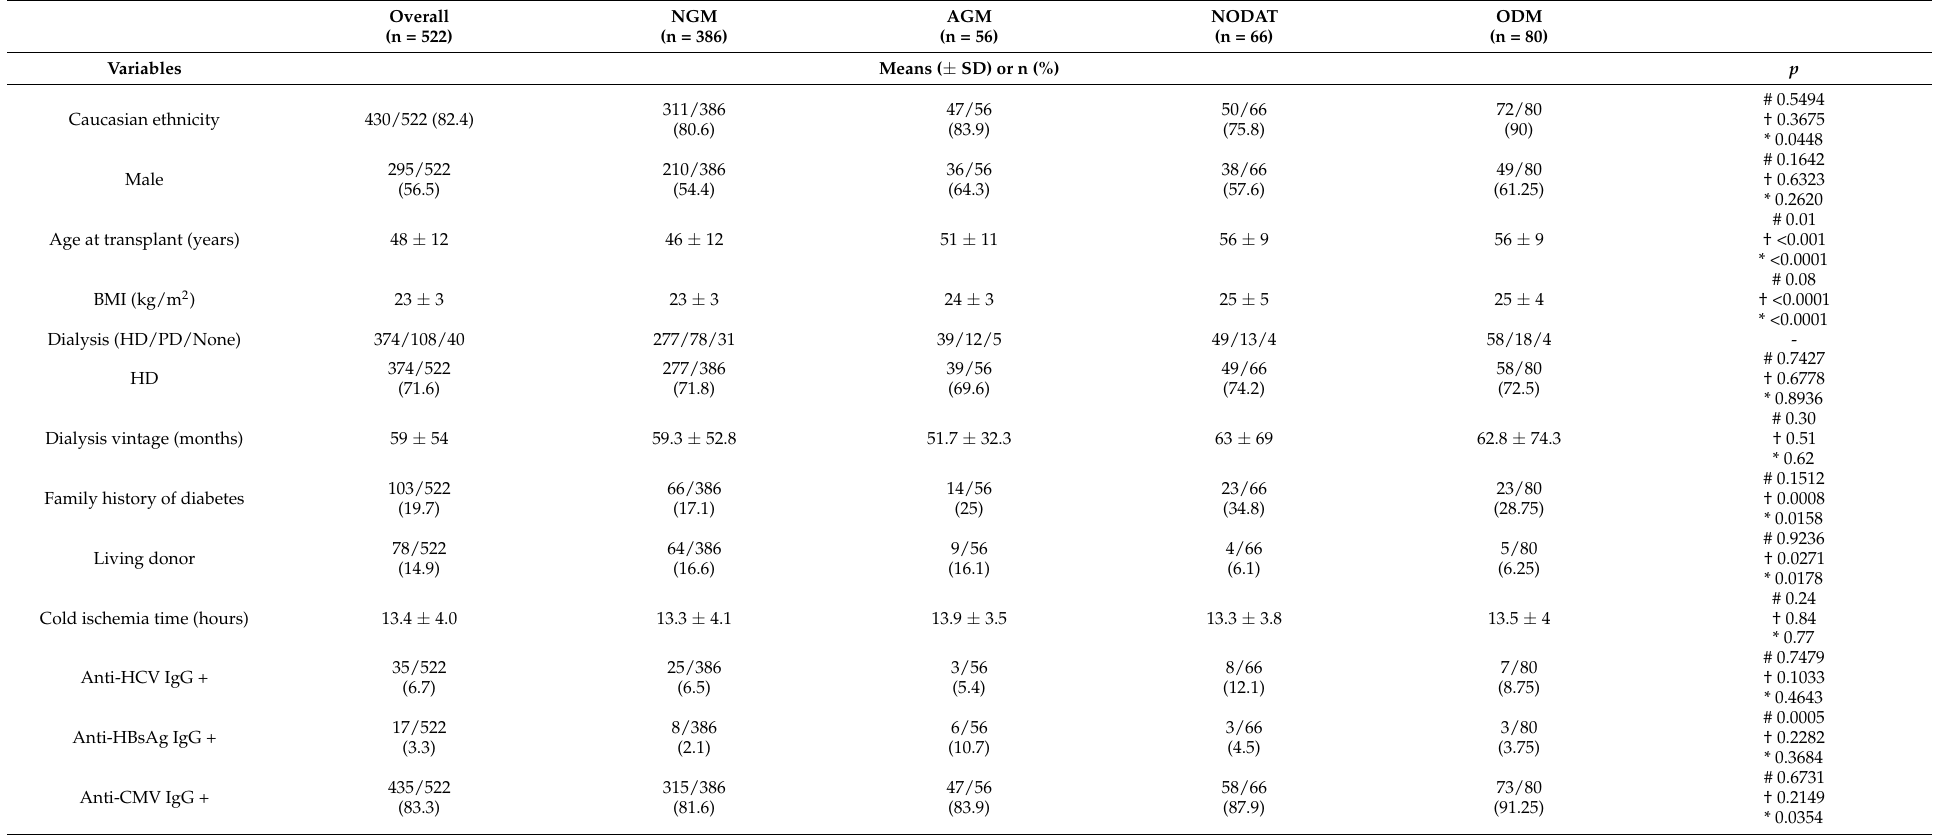
Table 1. Baseline characteristics of kidney transplant recipients with normal glucose metabolism (NGM), abnormal glucose metabolism (AGM), or new-onset diabetes mellitus after transplantation